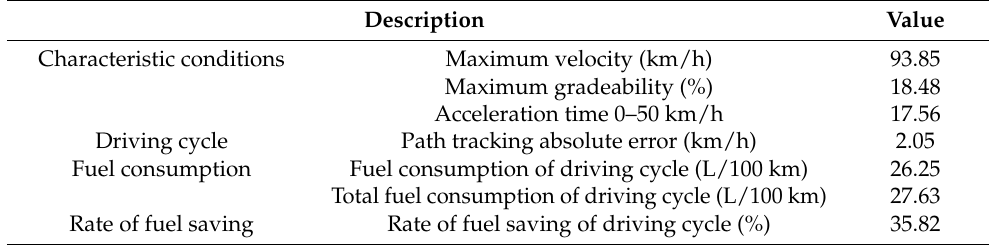
Table 5. Characteristic performance of single-axis power-split PHEV after optimization.